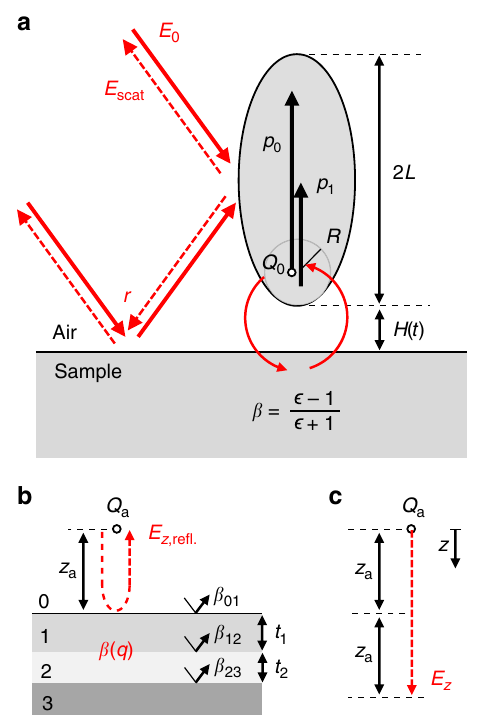
Fig. 4 Illustration of the fi nite dipole model for bulk and multilayered samples. a The nano-FTIR tip is modeled as a prolate spheroid of length 2 L and apex radius R , which is located at height H ( t ) above a bulk sample with permittivity ϵ and electrostatic re fl ection coef fi cient β = ( ϵ − 1)/( ϵ − 1). The incident electric fi eld E 0 induces the primary electric dipole p 0 , which interacts with the sample via the point charge Q 0 , yielding the near- fi eld induced dipole p 1 (indicated by red curved arrows). The model accounts for far- fi eld illumination and detection of the tip-scattered fi eld E scat via re fl ection at the sample surface, described by the Fresnel re fl ection coef fi cient r (indicated by red straight arrows). Illustration of ( b ) monopole fi eld re fl ected at a multilayer sample, E fi eld E z ,re fl , and ( c ) monopole z without sample. Both red dashed arrows have a length of 2 z a . The multilayer sample in b is characterized by the quasi-electrostatic re fl ection coef fi cient β ( q ), which is obtained from the single-interface electrostatic re fl ection coef fi cients β ij and layer thicknesses t j